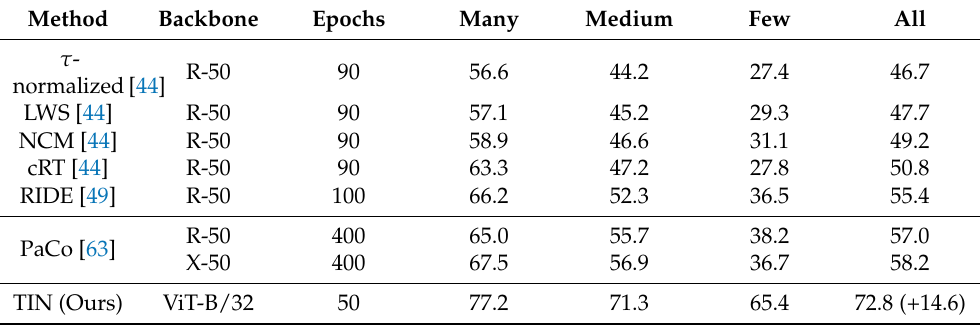
Table 4. Results obtained on ImageNet-LT.